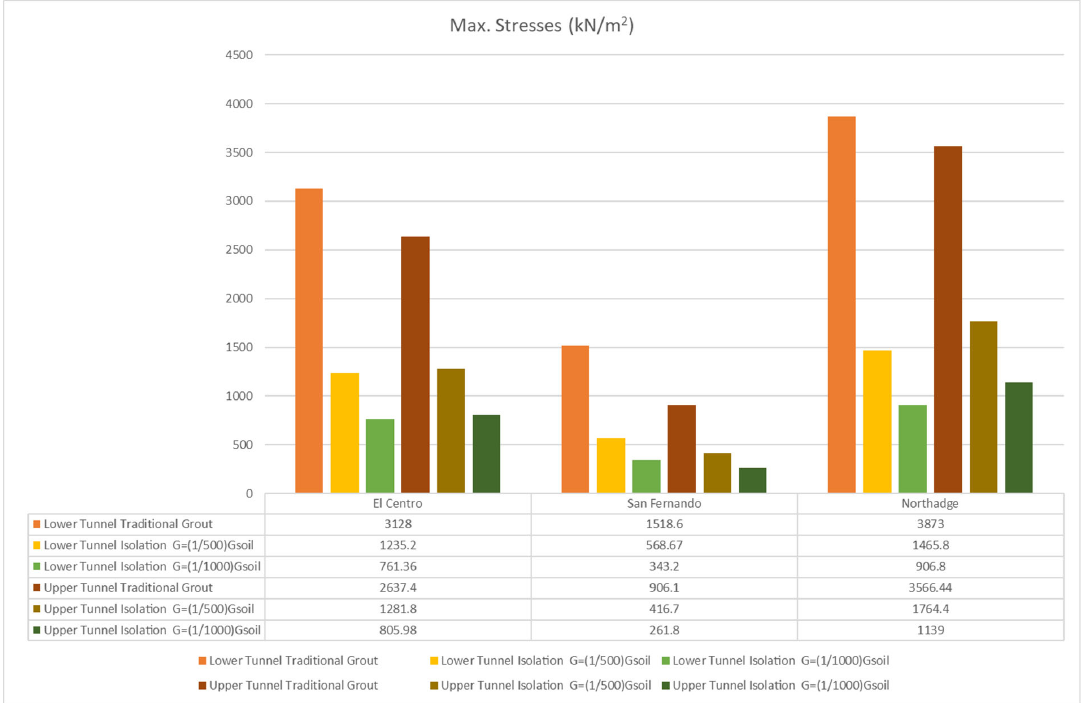
Figure 12. Maximum transverse stresses of twin tunnels in soft soil.